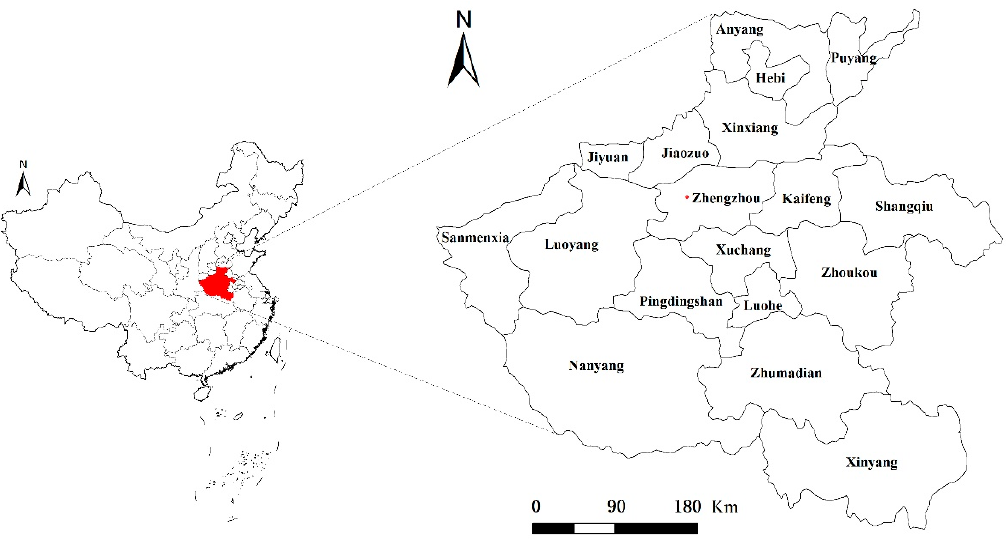
Figure 1. Location of the study area.